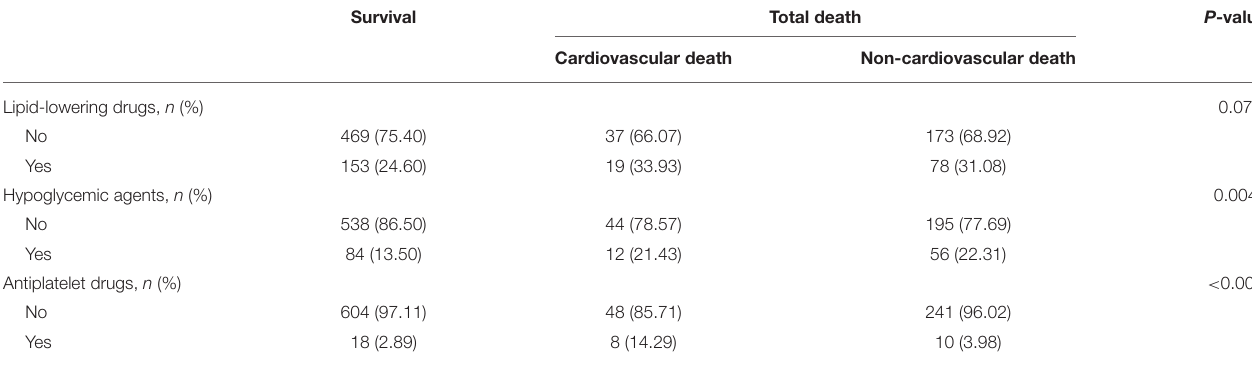
TABLE 3 | The association of selenium levels with all-cause mortality and cardiovascular mortality.